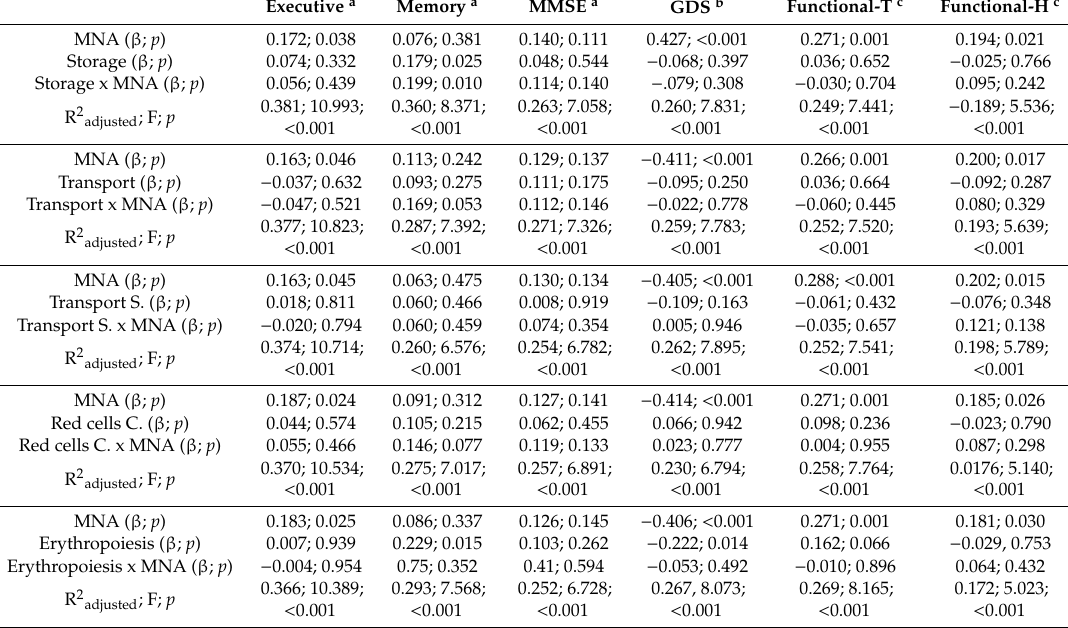
Table A6. Moderation analysis testing the e ff ect of nutritional status (MNA) on the association of hematological dimensions with cognition, mood and functional ability. Executive a Memory a MMSE a GDS b Functional-T